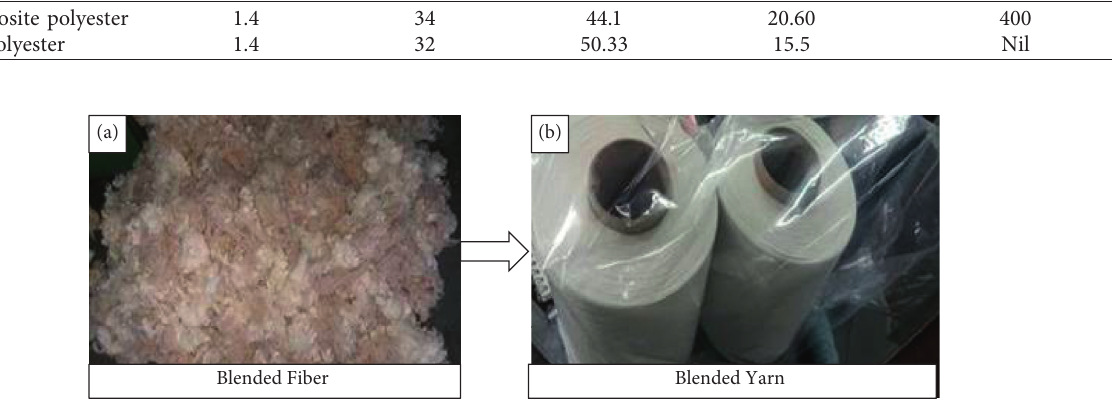
Table 1: Physical properties of fibers used: nanocomposite PET and recycled PET fibers. Materials